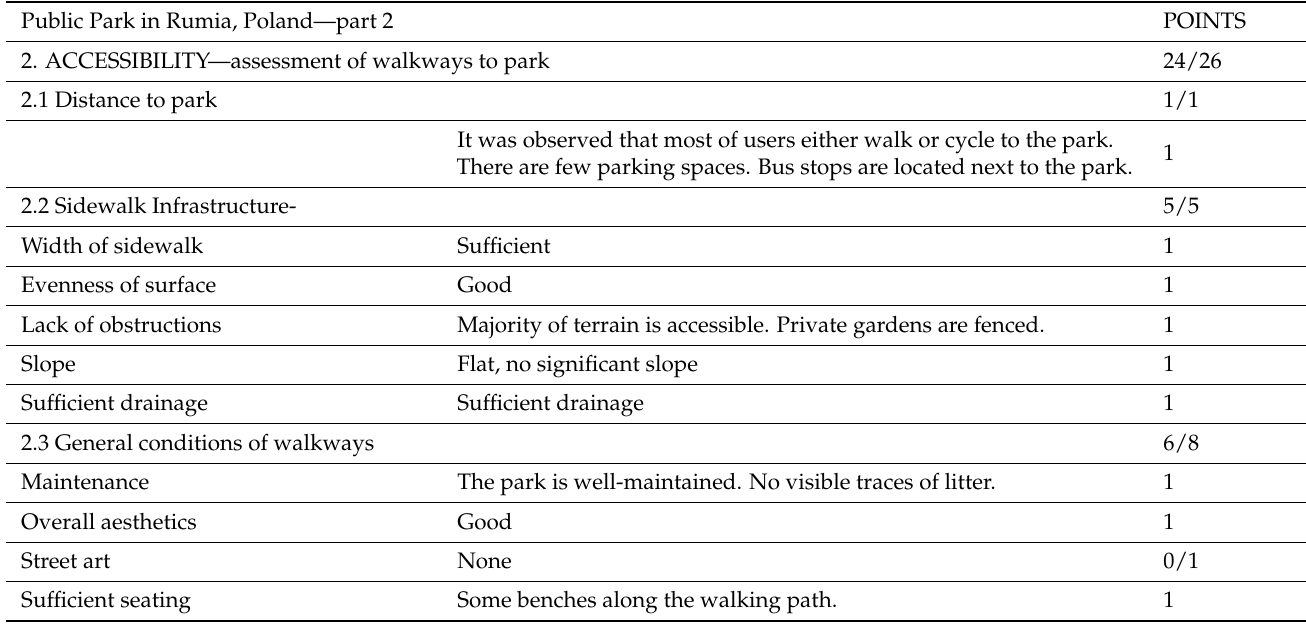
Table 2. Assessment of Public Park in Rumia, Poland—part 2, source: